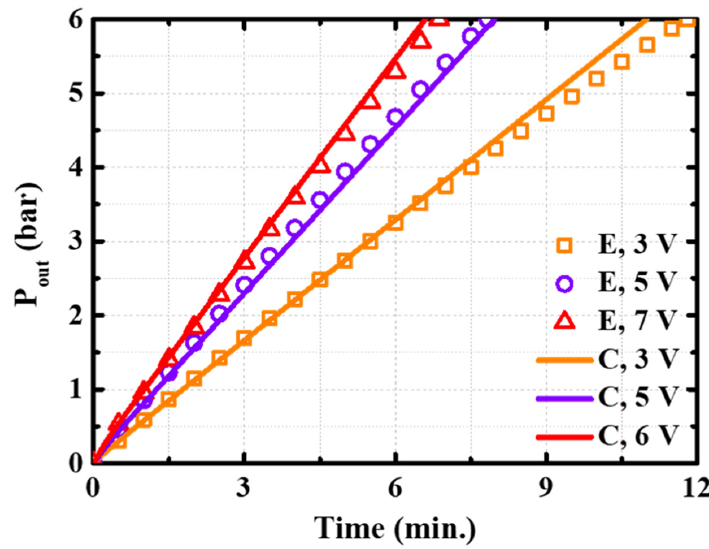
Figure 8. Comparison of the experimental and simulation results on cathode pressure.